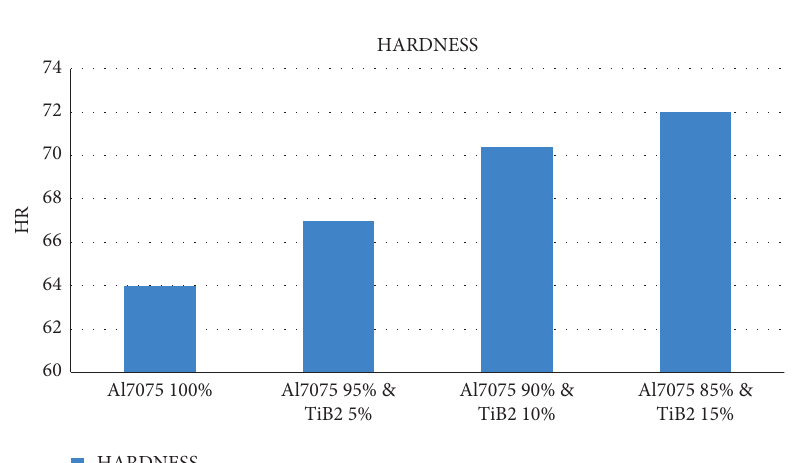
Figure 8: Hardness value